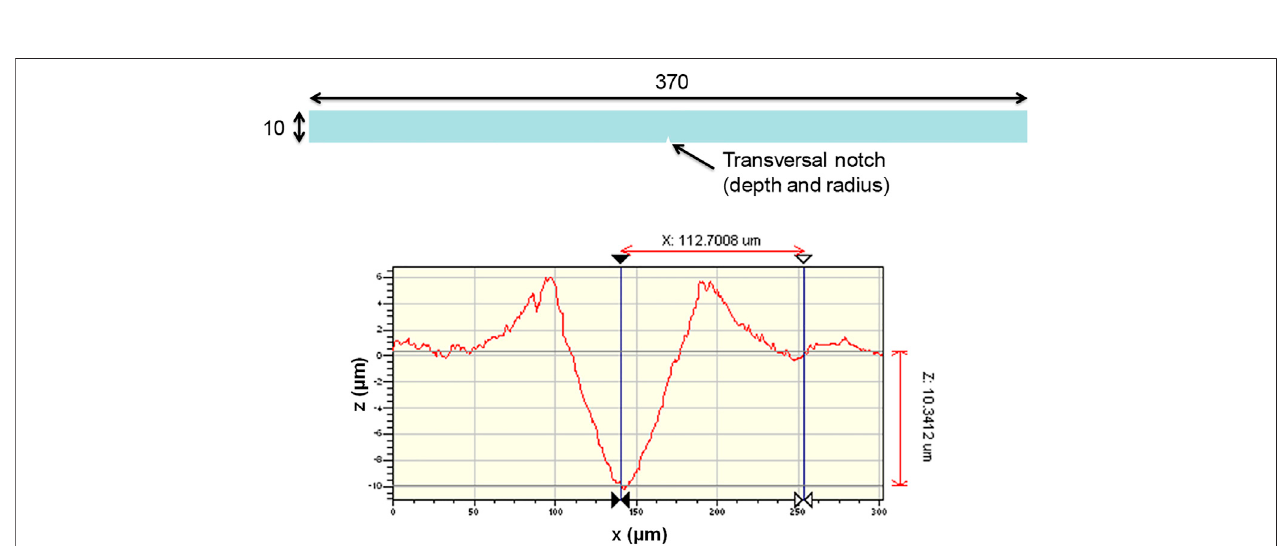
FIGURE 4 | Position of the notch on the specimen and example of the pro fi le using the glass cutting tool.